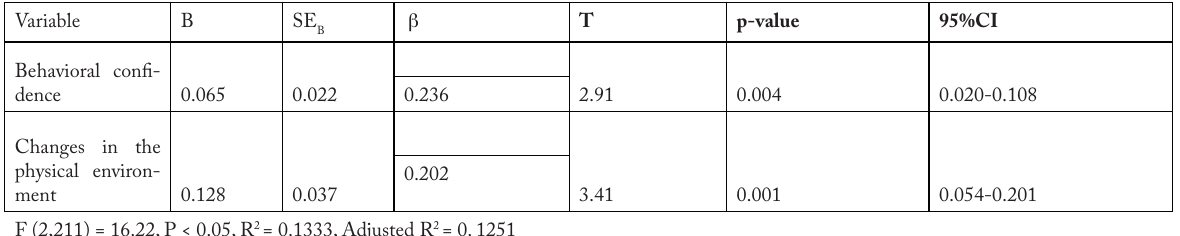
Table 3. Parameter estimates based on stepwise regression analysis* to predict intention for initiation of physical acti-